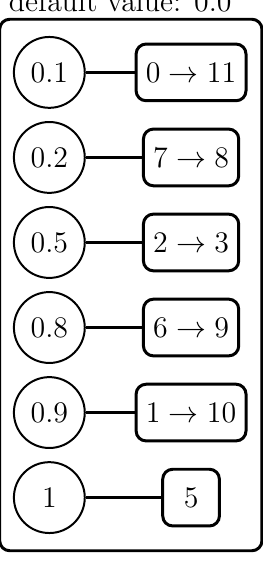
Figure 10. Potential to approximate. Table 1. Candidate structures for the first iteration. Bold typeface is used for the preferred candidate structure.